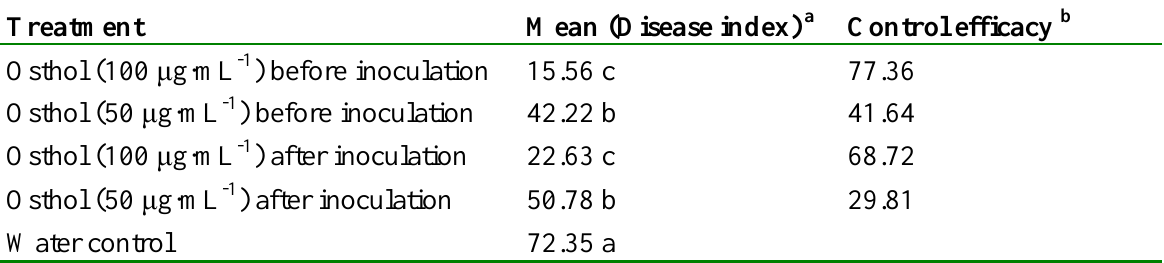
Table 1. Assessment of the efficacy of osthol against powdery mildew on cucumber leaves